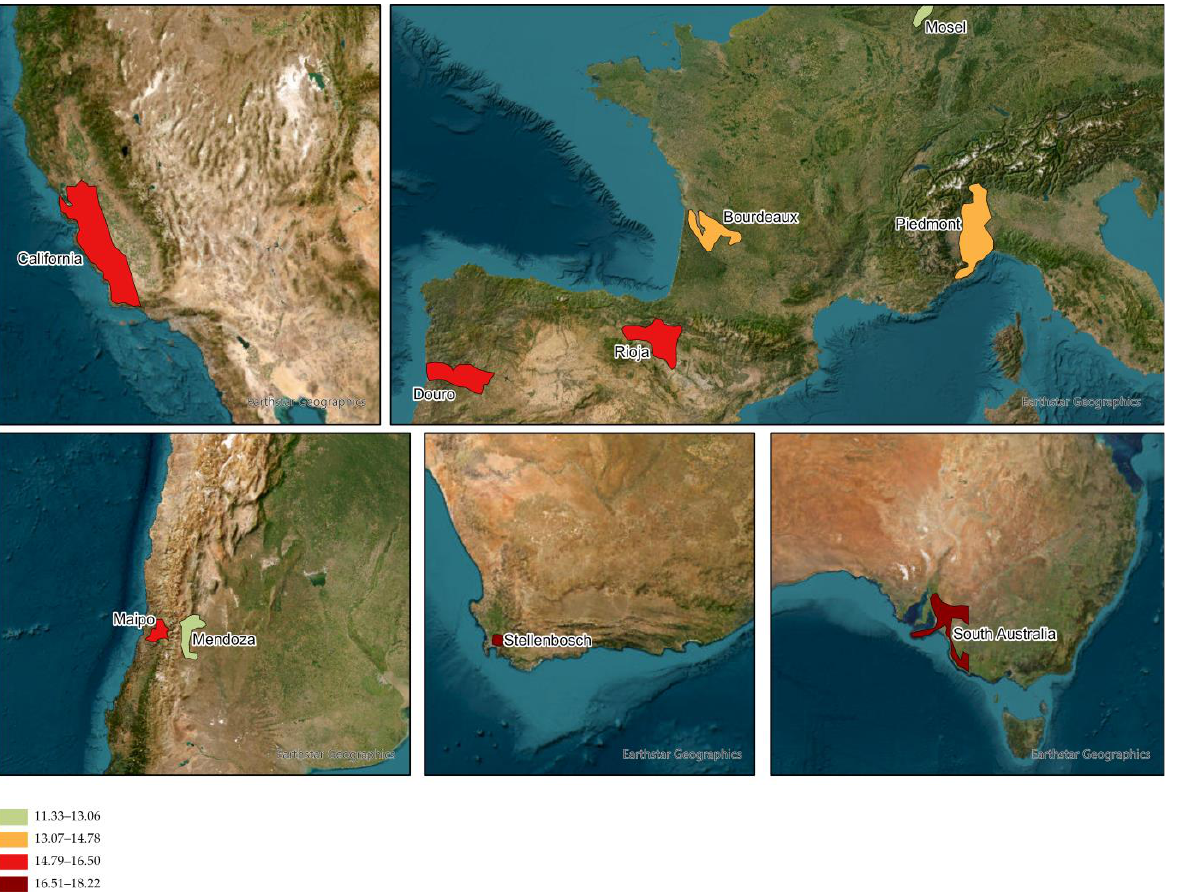
Figure 2. Average annual temperature for selected wine-producing regions for middle of century period (2041–2060) in Celsius. Source: GISS—average annual temperature for 2041–2060 [20], wine-producing regions manually created by the authors, World Imagery by Esri and Earthstar Geographics.